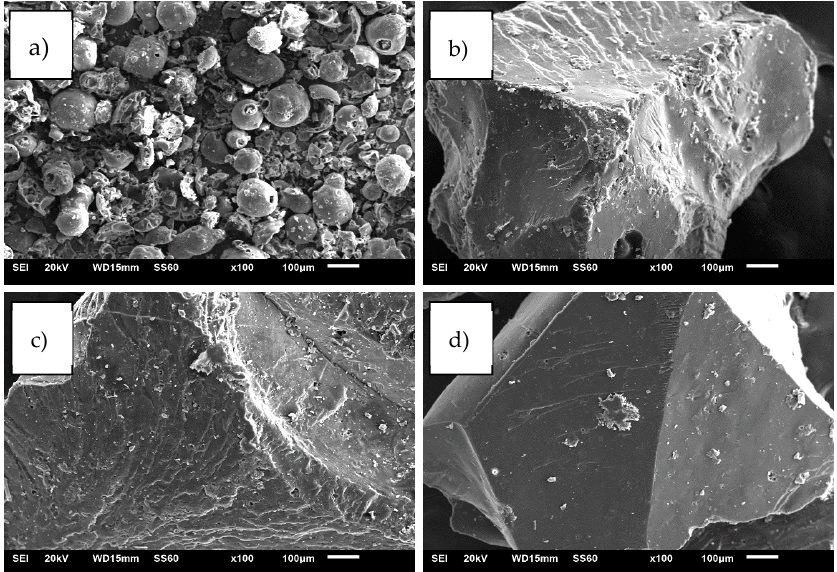
Figure 7. SEM micrographs for samples of ( a ) lignin, ( b ) LEBA5, ( c ) LEBA15, and ( d ) LEBA20.